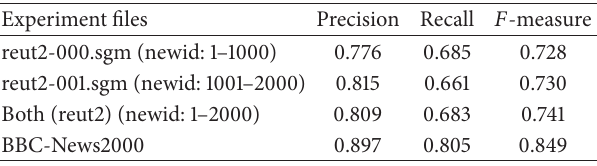
Table 8: Experimental results of